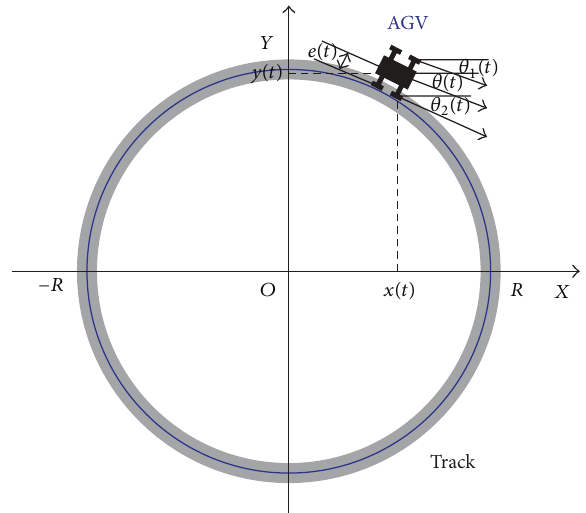
Figure 1: AGV tracking circular painted